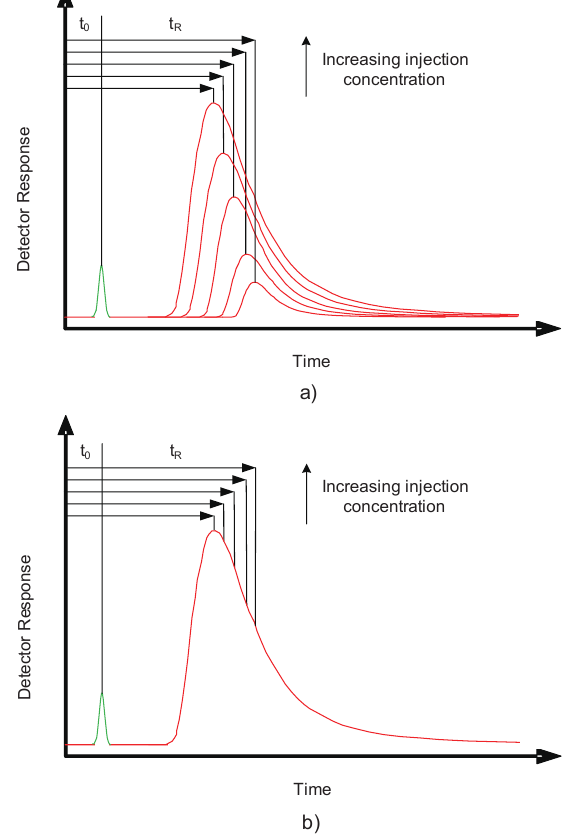
Fig. 5 Schematic of a) the PM method and b) the ECP